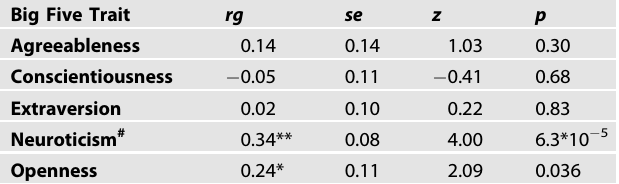
Table 2. Genetic correlations of Borderline Personality Disorder with Big Five personality traits.